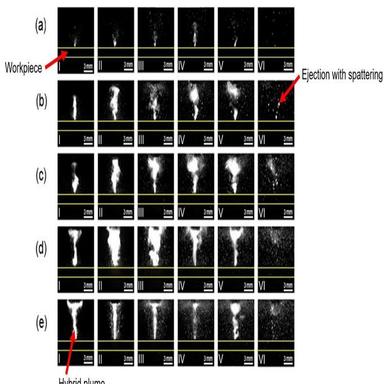
High-speed photography images showing the transient evolution of blind-hole drilling using the first laser pulse with different pulse energies of (a) 0.5 J, (b) 1 J, (c) 1.5 J, (d) 2 J and (e) 2.5 J.